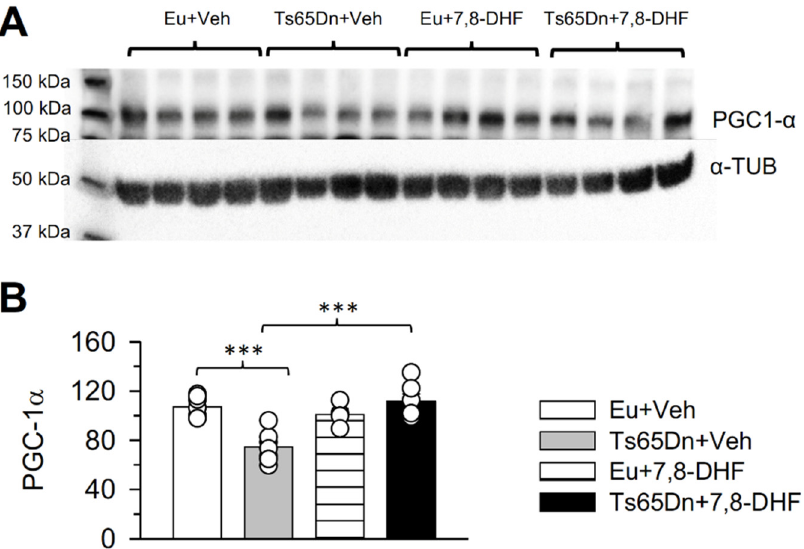
Figure 4. Outcome of treatment with 7,8-DHF in the neonatal period on PGC-1 α expression in the hippocampal formation of Ts65Dn and euploid mice aged 15 days. Western blot analysis of PGC-1 α expression in the hippocampus of P15 Ts65Dn and euploid mice treated either with vehicle (untreated mice) or 7,8-DHF (treated mice) during the postnatal days P3–P15. ( A ) Representative western blot images showing immunoreactivity for PGC-1 α and the housekeeping gene α -Tubulin. ( B ) Levels of PGC-1 α in the four experimental groups (untreated euploid and Ts65Dn mice and treated euploid and Ts65Dn mice). Values were normalized to α -Tubulin. Protein levels (mean ± SE) are expressed as a percentage of the values of untreated euploid mice. The scatterplots over each column represent the values of individual cases for each group. The following number of mice were analysed. Untreated euploid mice: n = 9; untreated Ts65Dn mice: n = 8; 7,8-DHF-treated euploid mice: n = 5; 7,8-DHF-treated Ts65Dn mice: n = 7. Two untreated euploid mice (yielding n = 7), one untreated Ts65Dn mouse (yielding n = 7), one 7,8-DHF-treated euploid mouse (yielding n = 4) and one 7,8-DHF-treated Ts65Dn mouse (yielding n = 6) were excluded from analysis based on the SPSS Box plot tool, as described in the Statistics section. *** p < 0.001 (Tukey’s test after two-way ANOVA). Abbreviations: 7,8-DHF, 7,8-dihydroxyflavone; α -Tub, α -Tubulin; Eu, euploid; Veh, vehicle.